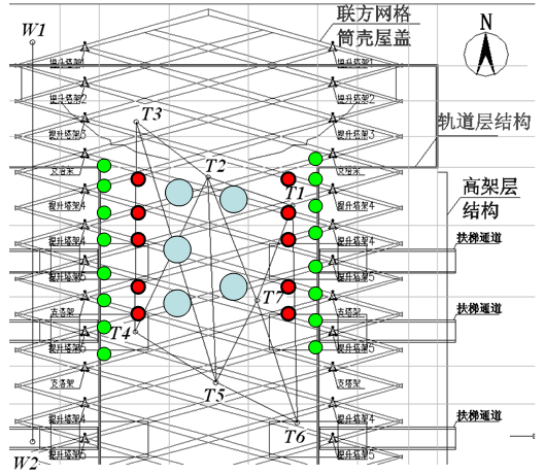
Figure 13 Scanning sites and control network of